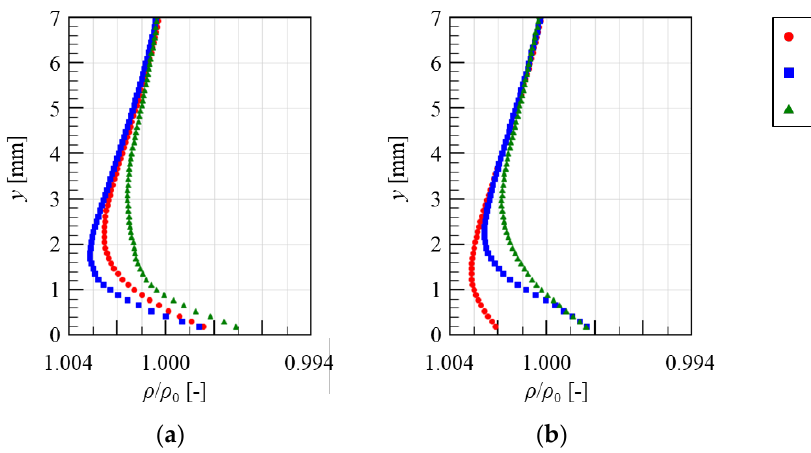
Figure 22. y -profiles of the density of ( a ) the plate-PA and ( b ) the wire-PA.